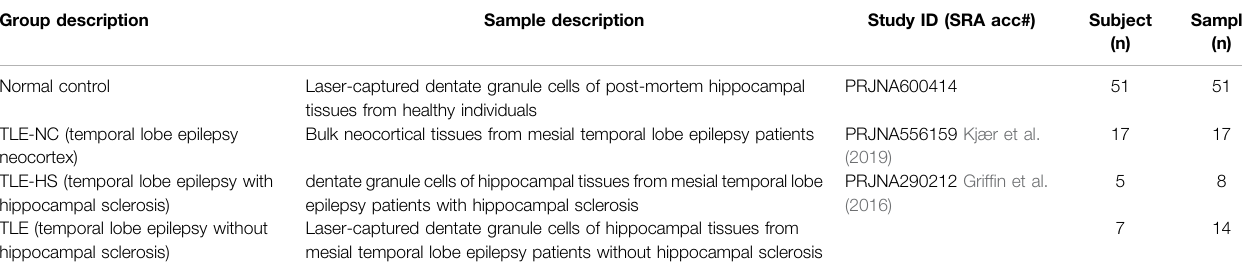
TABLE 1 | Human samples and groups used in this